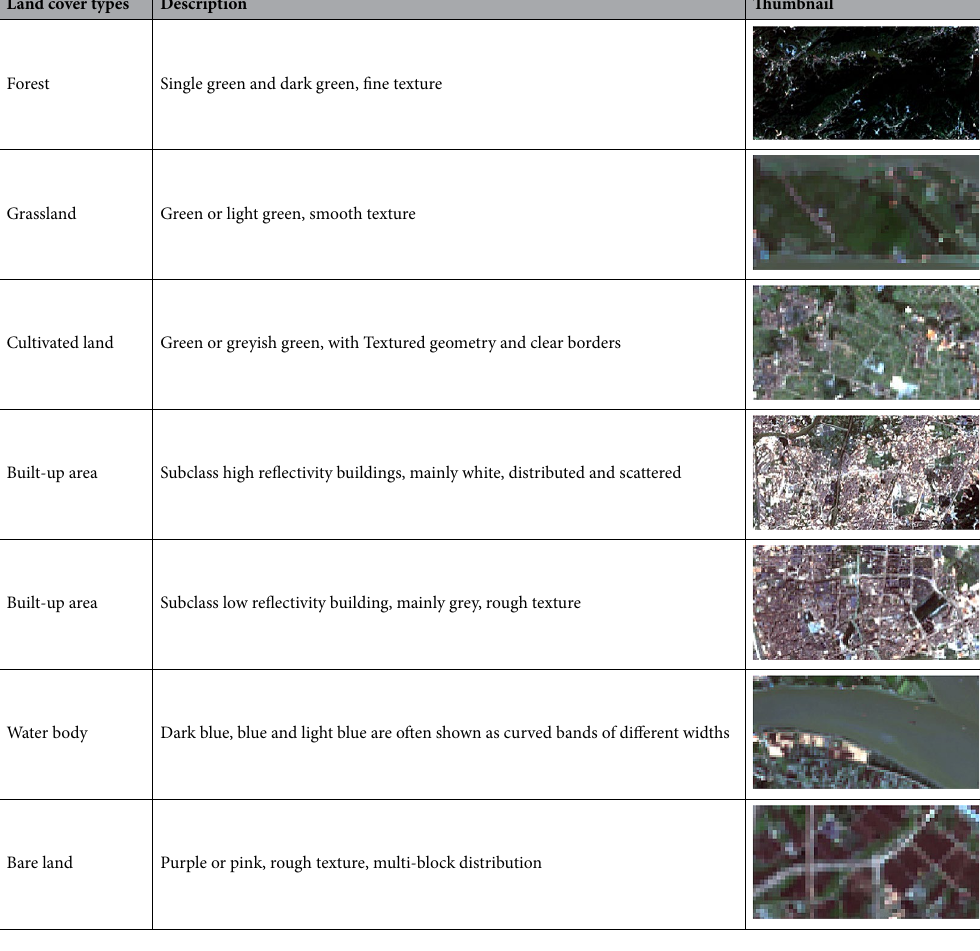
Table 1. Interpretation mark of land cover types.